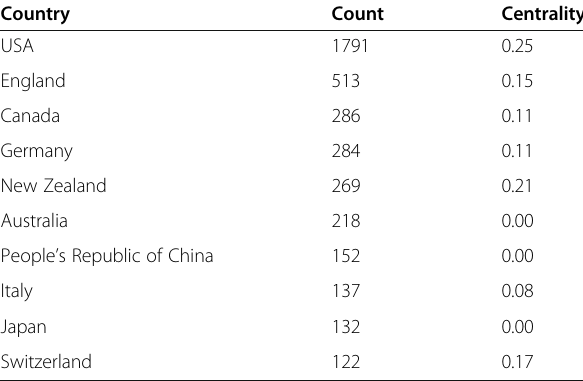
Table 2 Top 10 countries in the published volume and centrality of international database.